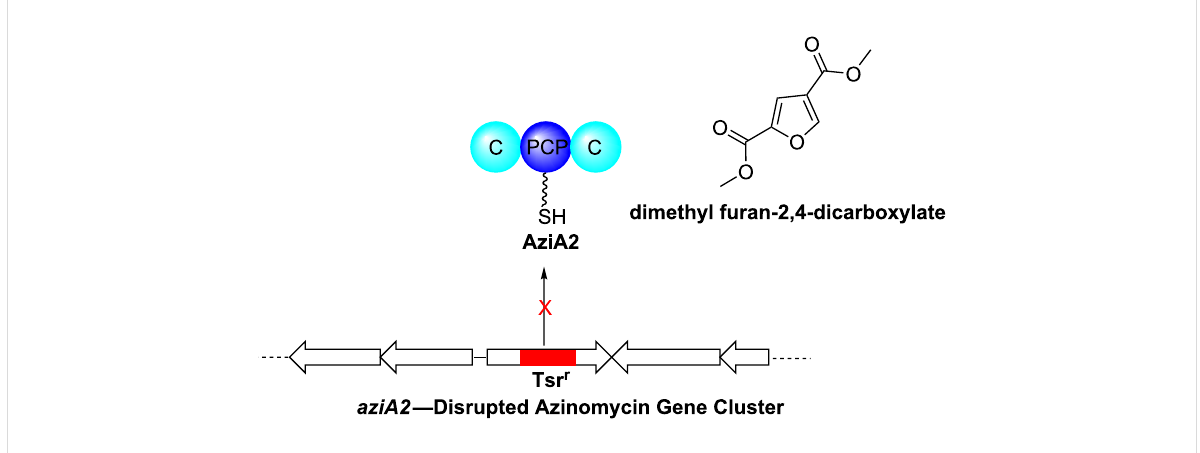
Figure 1: Schematic diagram illustrating the phenotypic effects arising through deletion of the aziA2 gene.